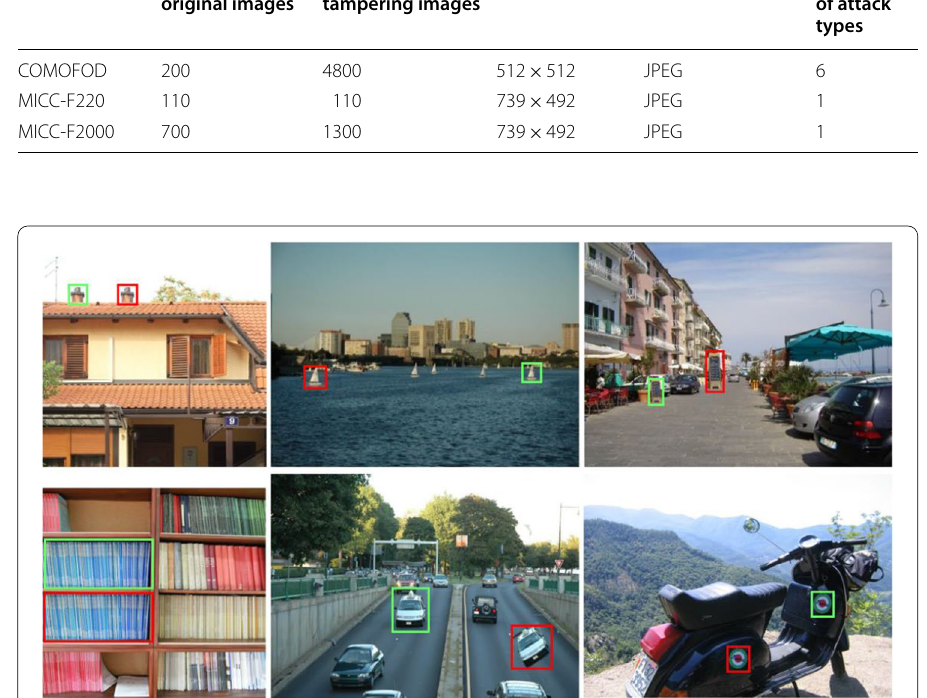
Fig. 9 Some examples in test images of three differents